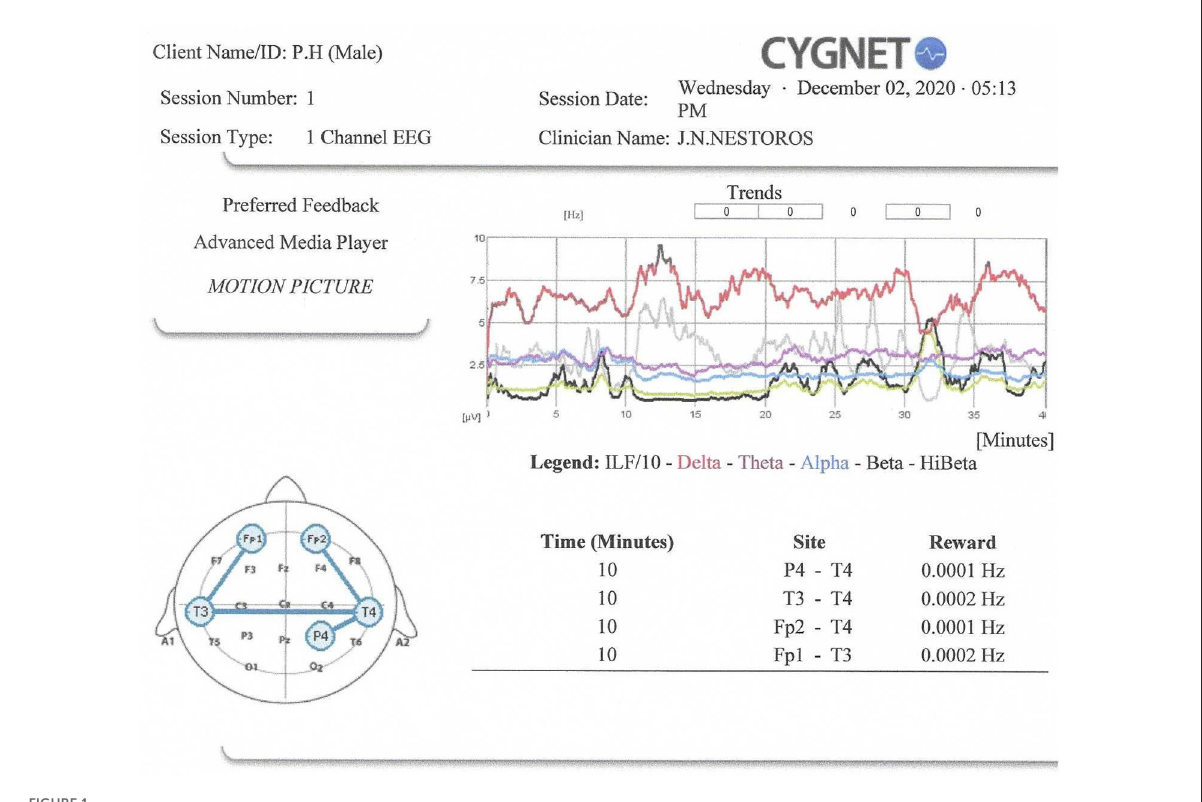
FIGURE1 Neurofeedback session